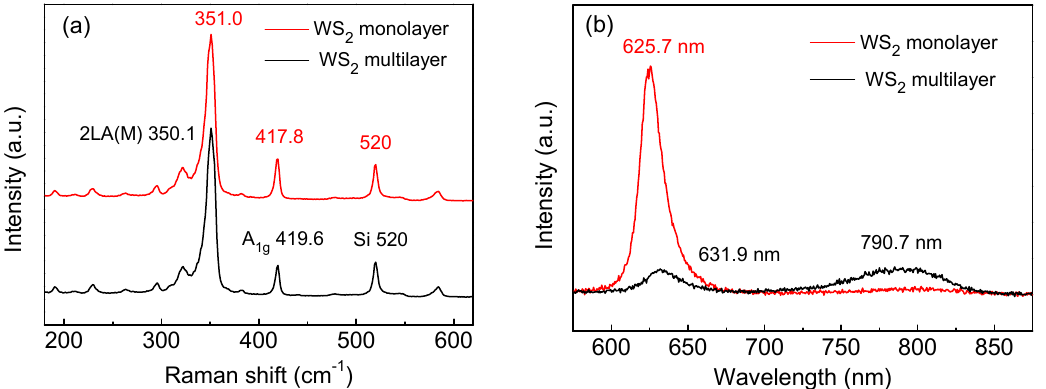
Figure 4. ( a ) Raman and ( b ) PL spectra of WS 2 monolayer (red line) and multilayer (black line) corresponding to the WS 2 domains in Figure 3a.